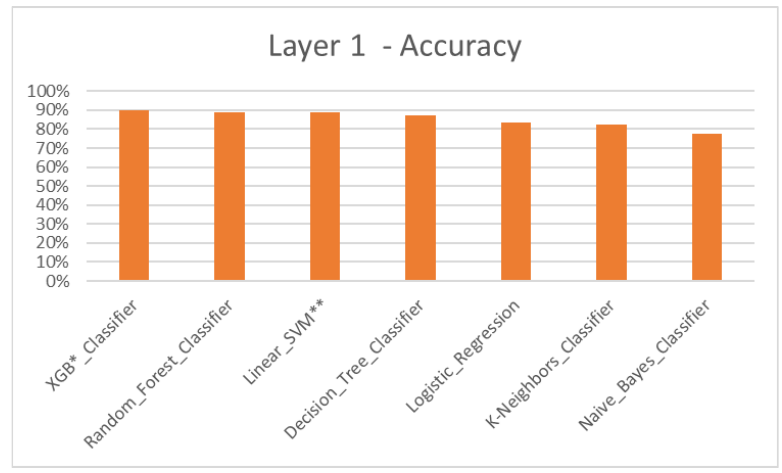
Figure 4. Layer 1 for prediction of skeletal jaw bases I, II and III — Accuracy. * XGB — eXtreme Gradient Boosting. ** SVM — Support Vector Machine. Table 5. Layer 2 — Accuracy.